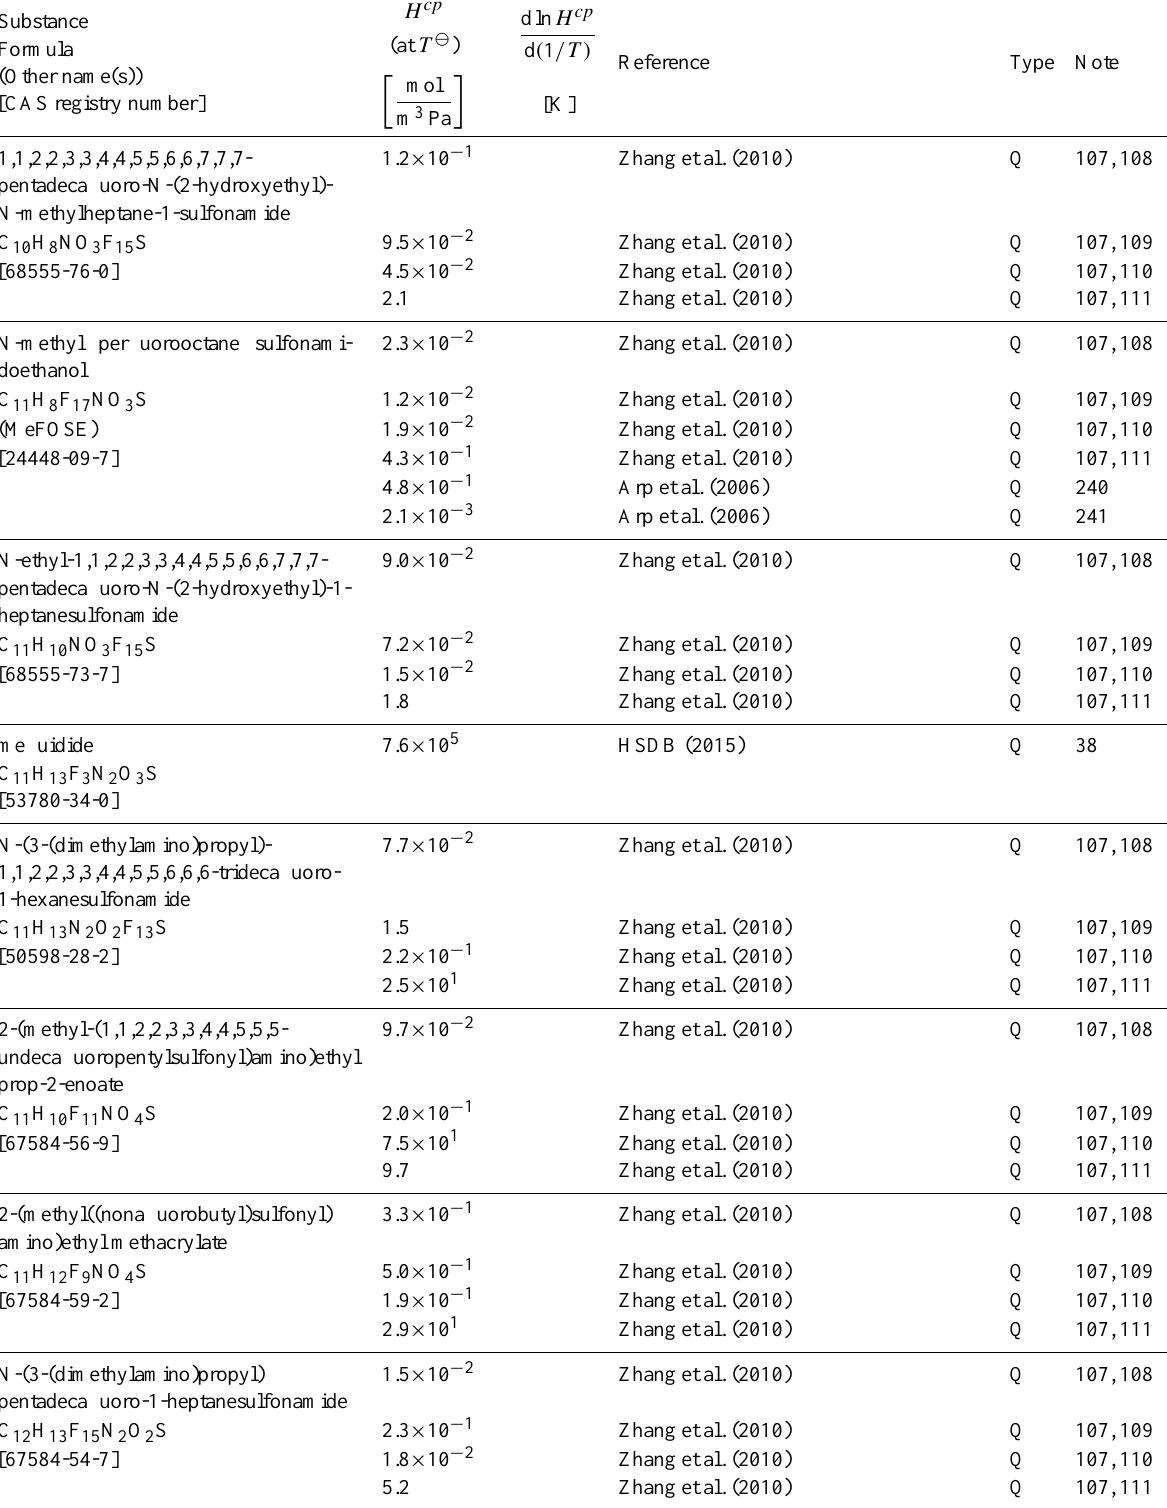
Table 6: Henry’s law constants for water as solvent